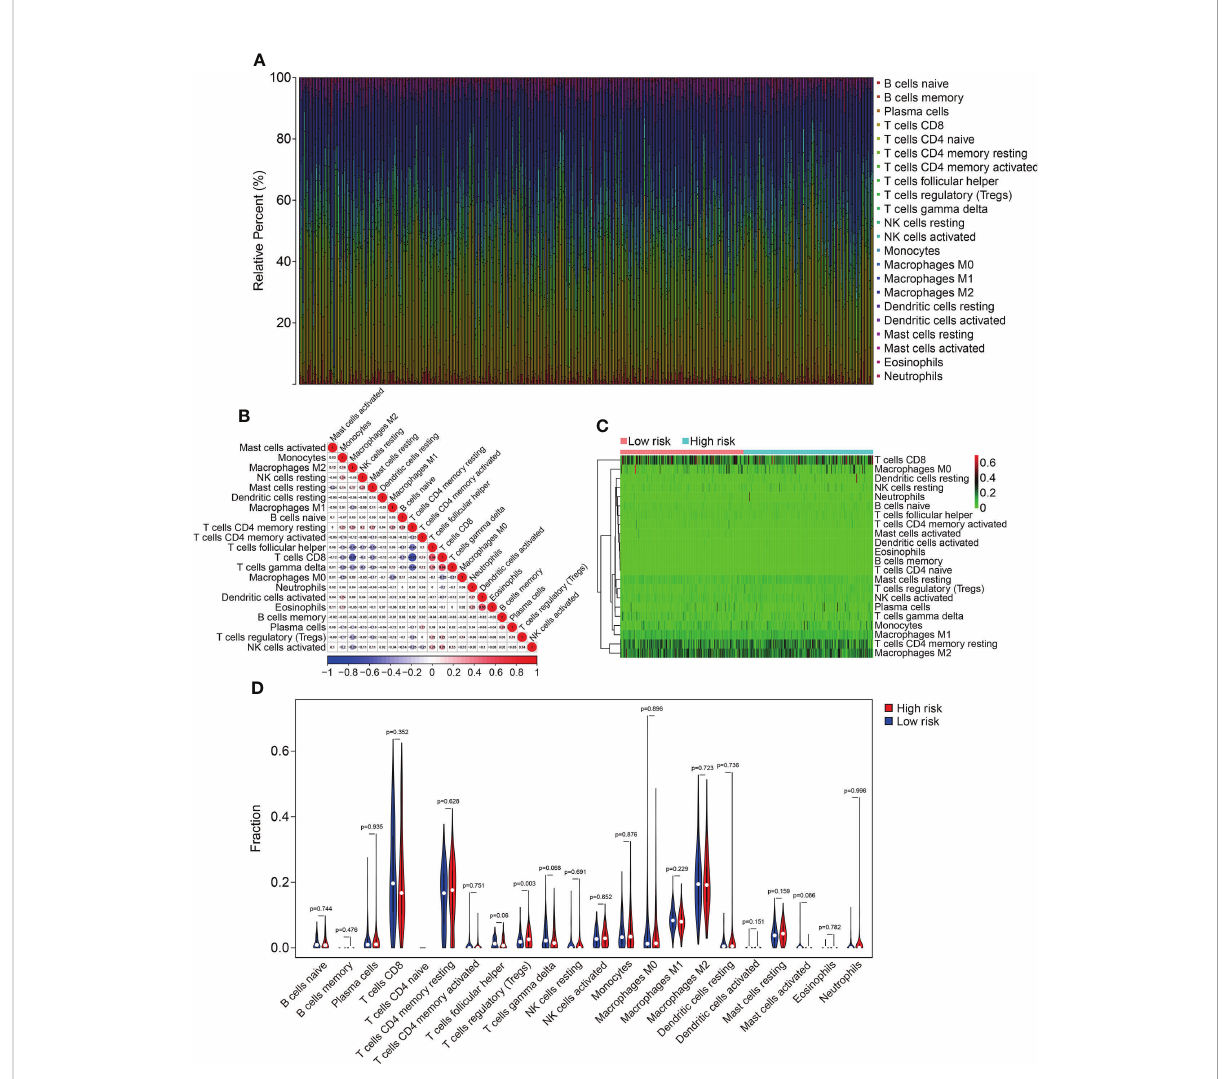
FIGURE 8 Comparison of immune cell in fi ltration in high- and low-risk groups in TCGA cohort. (A) Relative abundance of immunocyte in fi ltration in KIRC samples of the TCGA cohort. (B) The heatmap showing the correlation of in fi ltrating immune cells in the TCGA cohort. (C, D) The fraction of 22 immune cell types in high- and low- risk groups of the TCGA